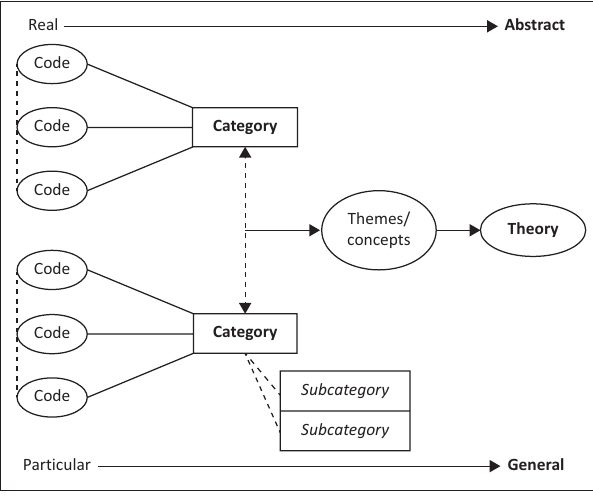
FIGURE 3: Codes-to-theory model for qualitative